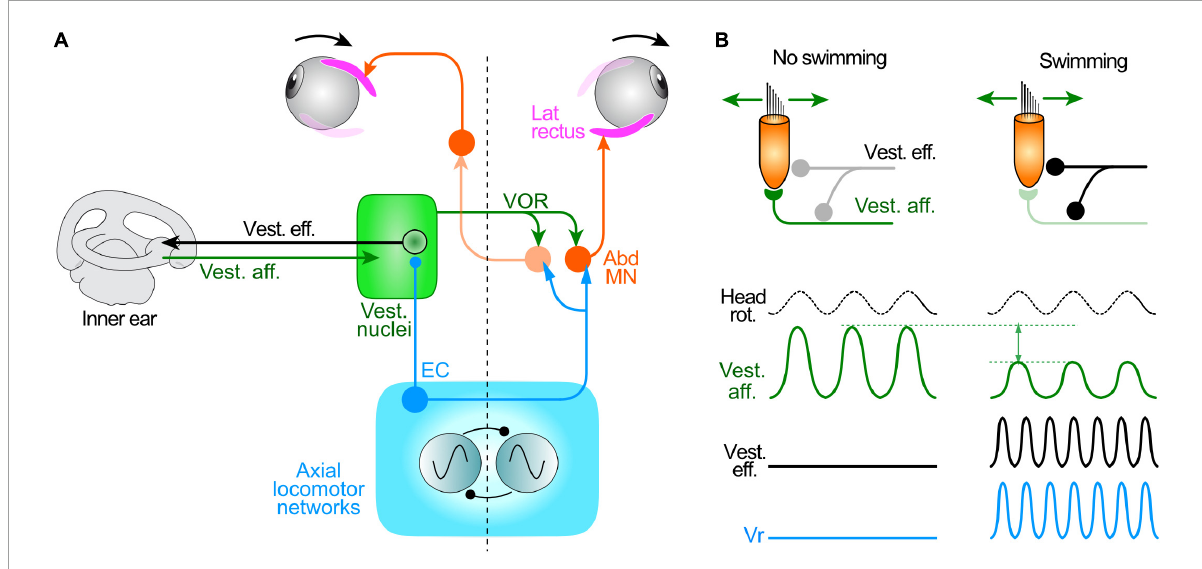
FIGURE5 Attenuation of mechanosensory signal encoding in the inner ear during locomotor activity in larval Xenopus . (A) Summary schematic of the circuit elements mediating the vestibulo-ocular reflex (VOR), spino-ocular motor coupling and activation of inner ear vestibular efferent neurons (Vest. eff.) by locomotor ECs. (B) Influence of locomotor activity conveyed by Vest. eff. onto hair cells and vestibular afferent neurons (Vest. aff.); during swimming (right), the overall responsiveness of vest. aff. (magnitude of the sine wave) to imposed cyclic head rotation is substantially reduced compared to the condition without swimming (left). Abd MN, abducens motoneurons; Vr, spinal ventral